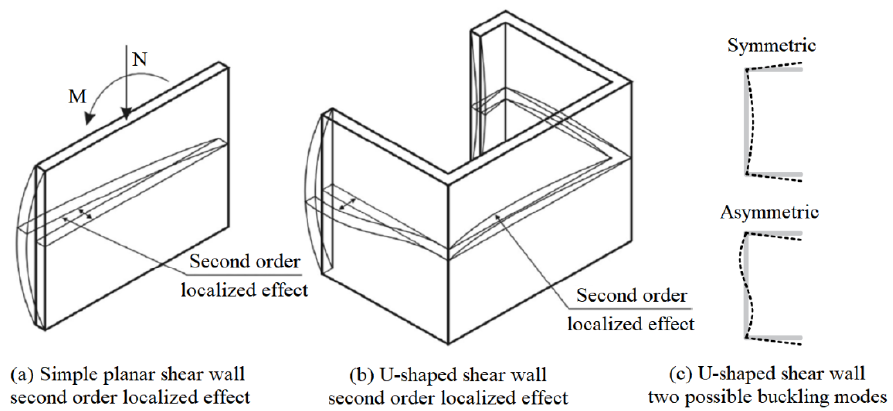
Figure 4. Shear walls second order localized effects and buckling modes